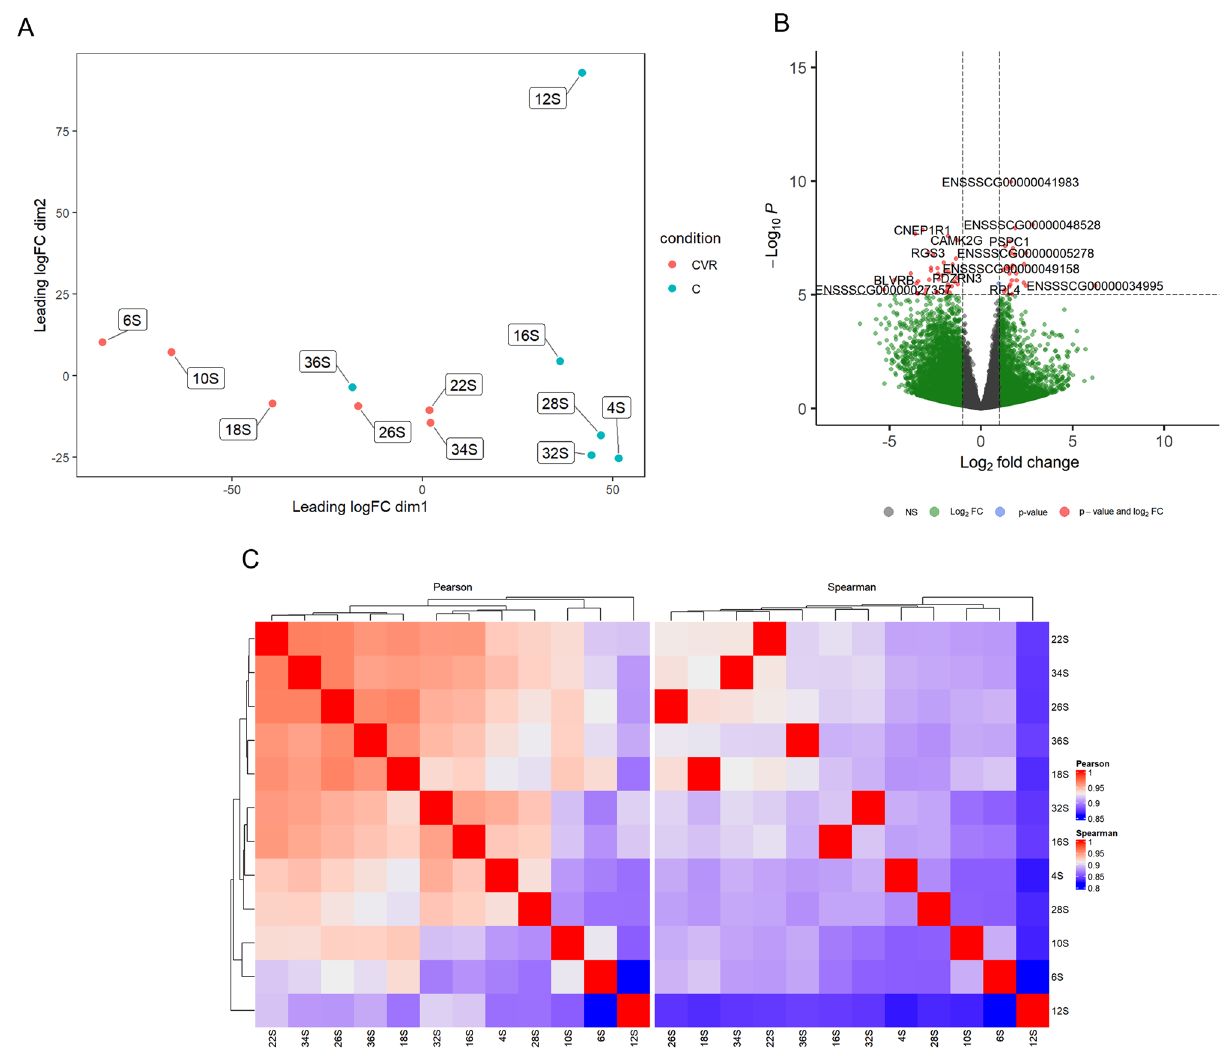
Figure 3. ( A ) Multi-dimensional scaling (MDS) plot showing the relation between Control and CV + R diet samples. ( B ) Volcano plot showing the relationship between FC and evidence of differential expression (-log FDR) for Control vs CV + R. ( C ) Clustering of sample to sample correlations—Control vs CV + R. Hierarchical clustering of treatment condition samples based on Pearson (left) and Spearman correlations